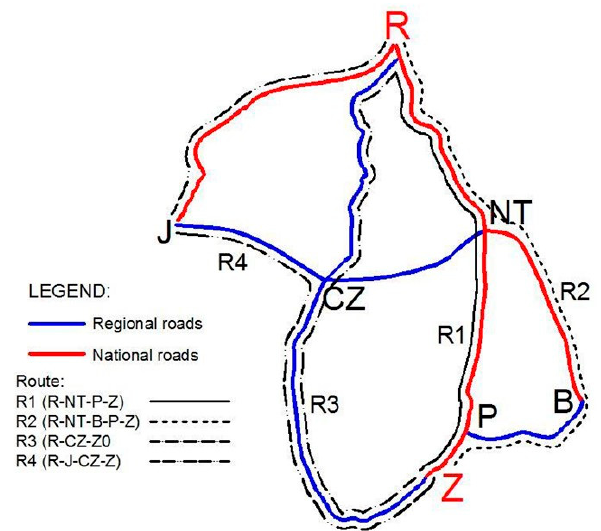
Figure 1. National and regional road network included in the analysis and alternative route identification.